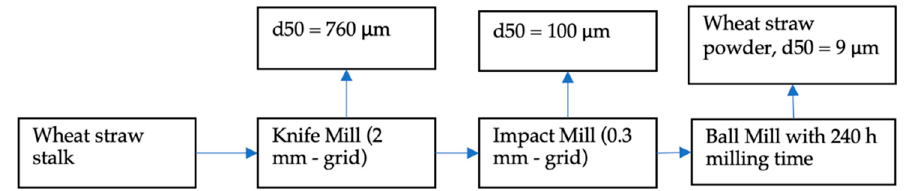
Figure 4. Process diagram for the wheat straw milling up to a median size below 10 µ m [52].